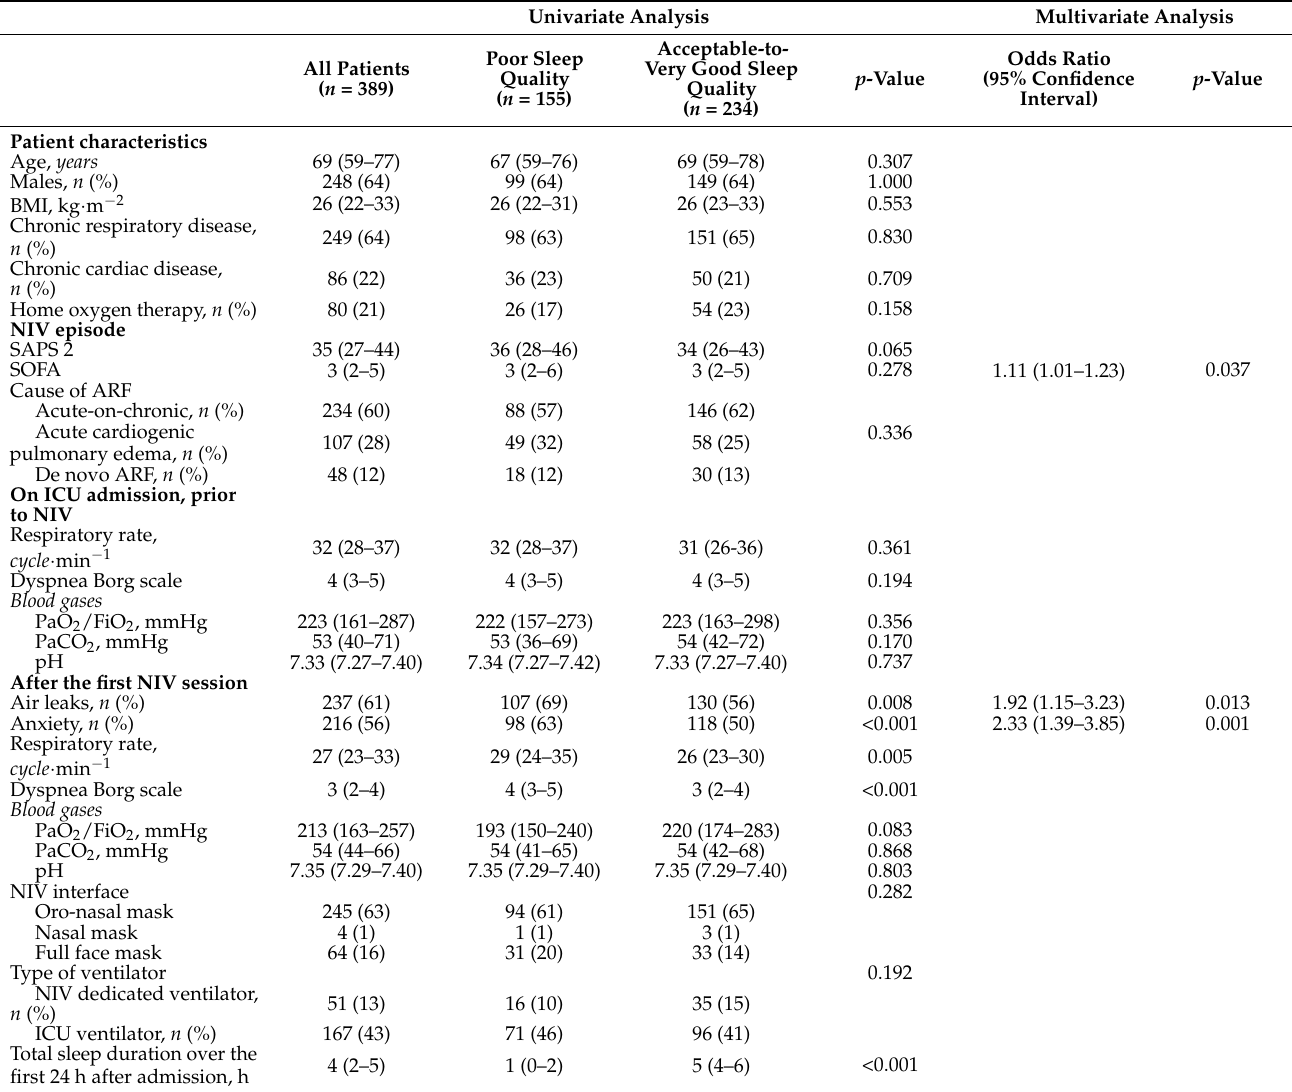
Table 1. Univariate and multivariate analysis: factors associated with poor perceived sleep